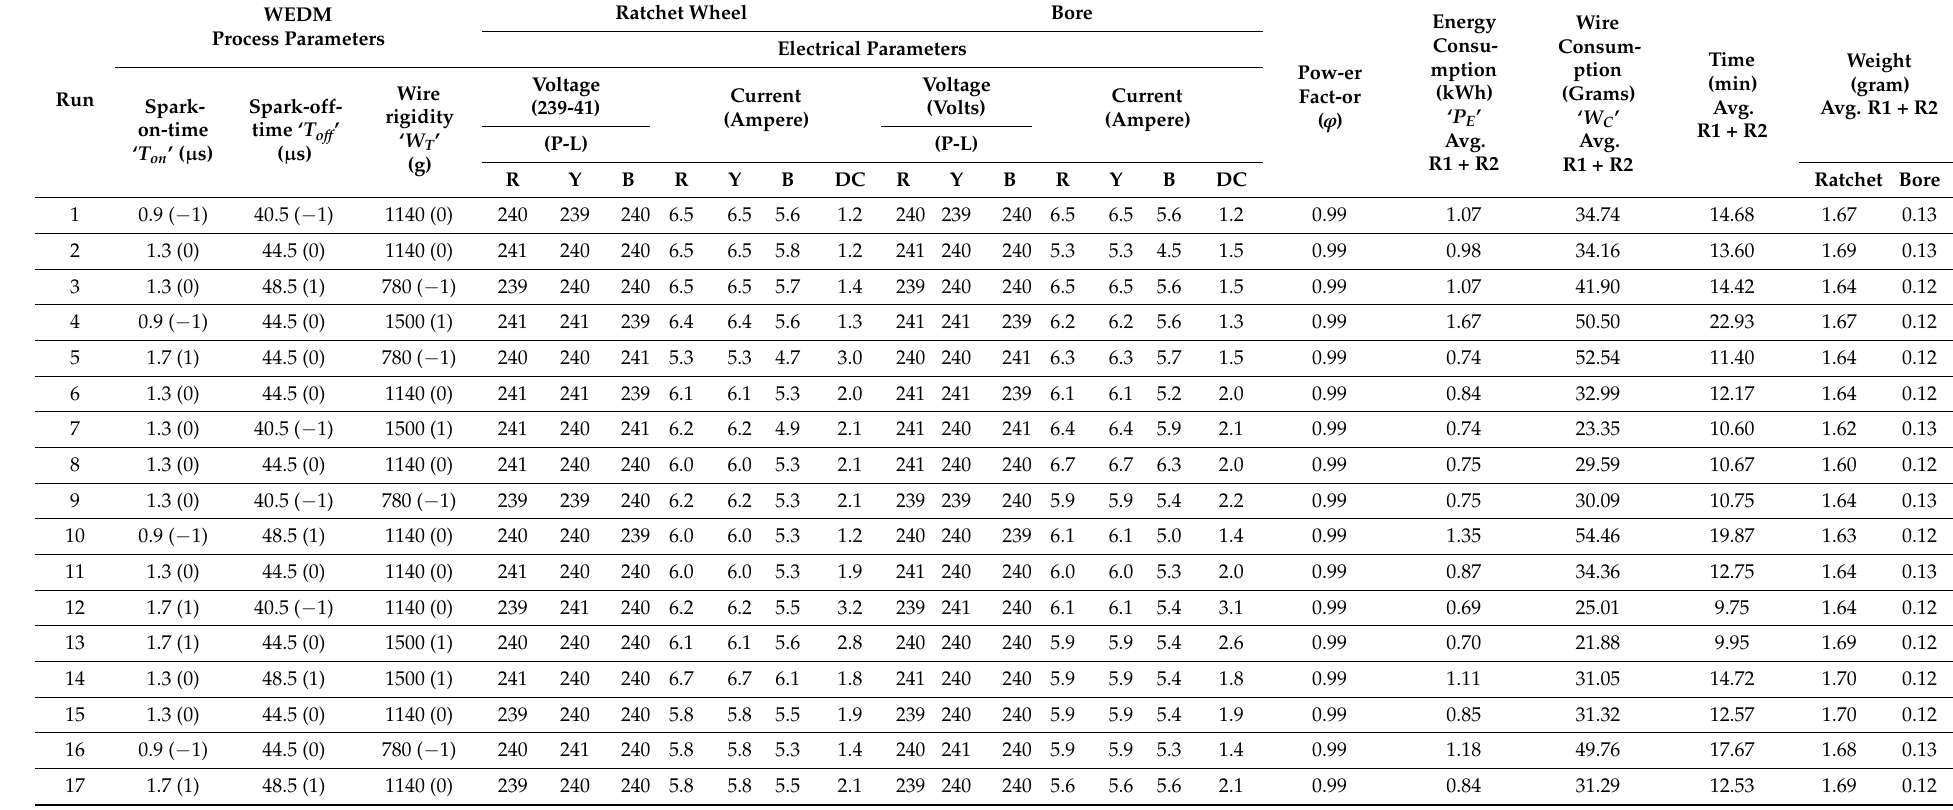
Table 2. Combinations of process parameters for seventeen experiments with two replicates and corresponding average values of